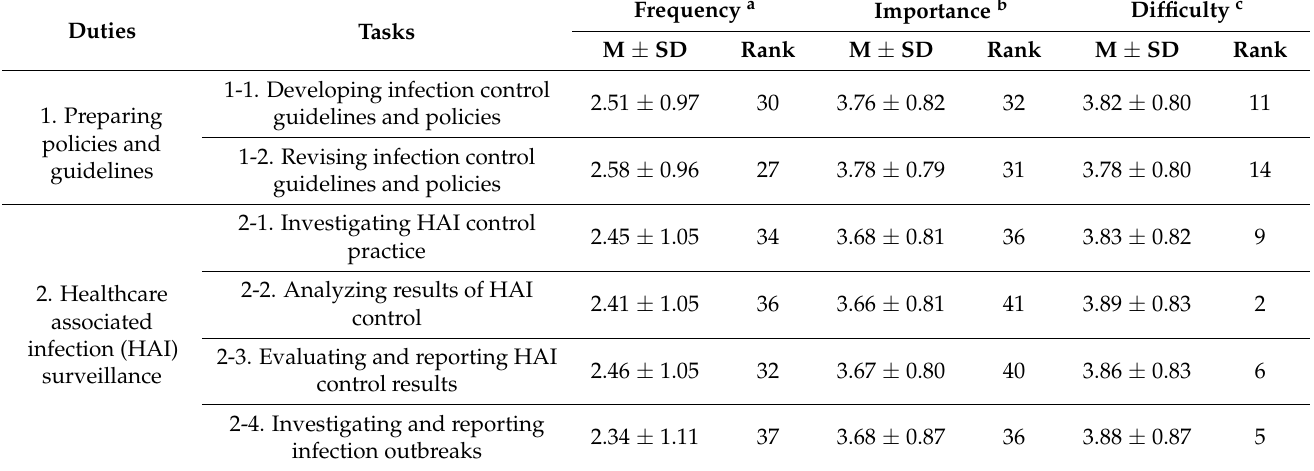
Table 1. Degree of Frequency, Importance, and Difficulty of Duties and Tasks (N =